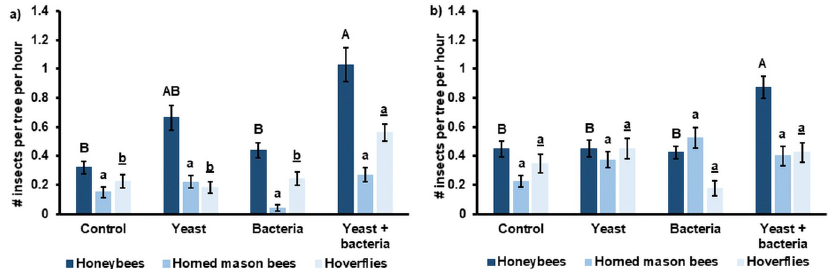
Fig 2. Average number of honeybees, horned mason bees and hoverflies foraging per tree per hour (N = 15) for each inoculation treatment applied in 2019 (a) and 2020 (b). Treatments included inoculation of flowers with Metschnikowia reukaufii (yeast), Acinetobacter nectaris (bacteria), and a combination of both (yeast + bacteria). As a control, flowers were sprayed with water. Statistics were performed separately on each pollinator group, indicated with different letter fonts: capitals for honeybees, lower case for horned mason bees and lower case underlined for hoverflies. Treatments with different letters within one pollinator group differ significantly (P < 0.05). Error bars represent standard errors of the mean.